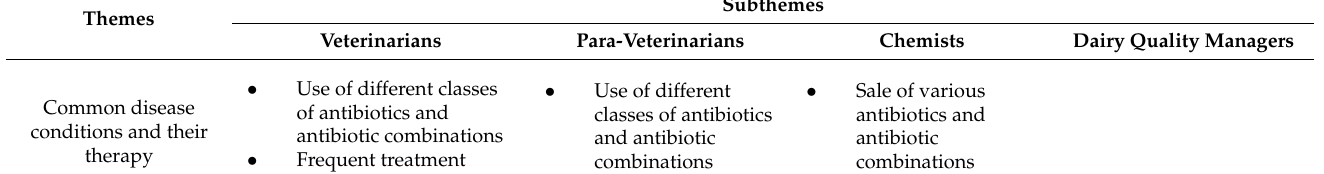
Table 2. Various discussion themes and subthemes emerged from the focus group discussions (FGDs) and key informant interviews (KIIs) of various